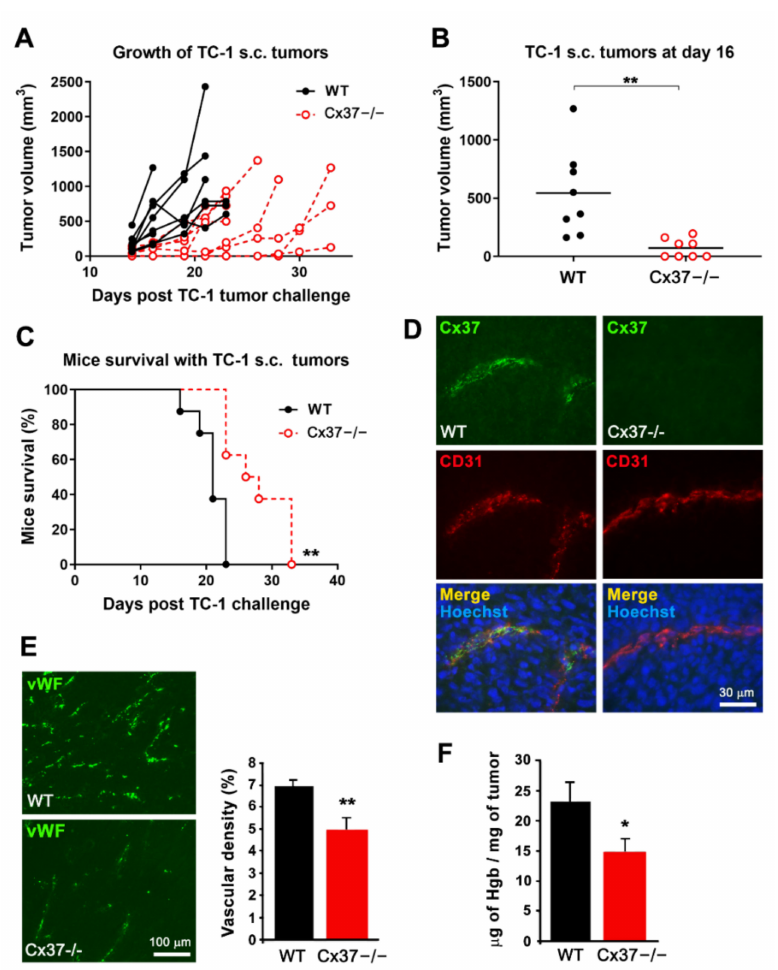
Figure 3. The growth of TC-1 tumors is reduced in Cx37 − / − mice. ( A ) After s.c. injection, TC-1 cells generated growing tumors in all WT and Cx37 − / − mice. ( B ) Sixteen days after the cell injection, the volume of tumors was significantly lower in Cx37 − / − ( n = 8) than in WT mice ( n = 8). ** p < 0.01 versus WT mice (Student’s t -test). The horizontal bars show the mean tumor volume in each group. ( C ) All WT mice carrying the TC-1 tumor were sacrificed within the first 3 weeks of the experiments. In contrast, the cognate Cx37 − / − mice survived significantly longer. ** p = 0.01 versus WT mice (log-rank Mantel-Cox test). ( D ) Sixteen days after the injection of TC-1 cells, Cx37 was detected via immunostaining in CD31-positive EC of the tumors grown in WT (left) but not Cx37 − / − mice (right). Bar, 30 µ m. ( E ) Immunostaining of the EC-specific von Willebrand factor (vWF) revealed a lower density of vessels in the tumors grown in Cx37 − / − than in WT mice. Data are mean + SEM of 5–7 areas from size-matched tumors that developed in 4 mice per group. ** p < 0.01 versus WT mice (Student’s t -test). Bar, 100 µ m. ( F ) The hemoglobin concentration was also lower in the tumors that developed in Cx37 − / − than WT mice. Data are mean + SEM. n = 6 mice per group. * p < 0.05 vs. WT mice (Student’s t